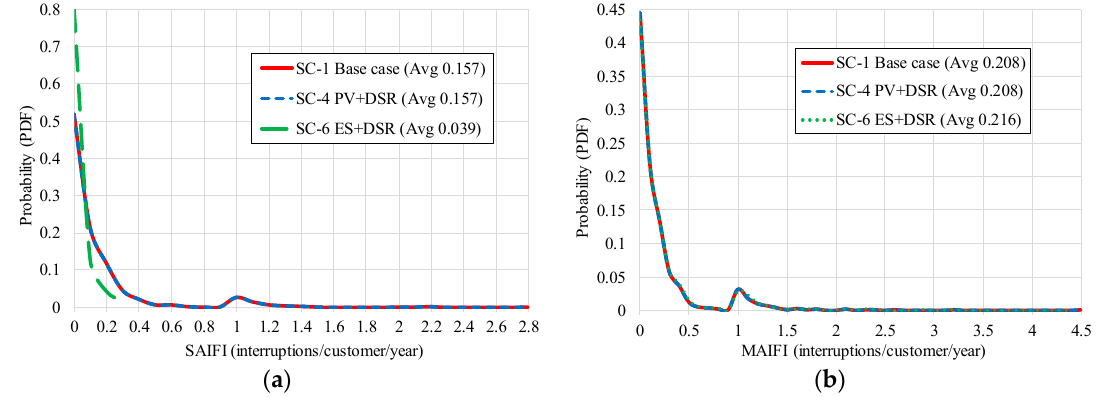
Figure 10. Probability distribution of the frequency of ( a ) sustained and ( b ) momentary interruptions.